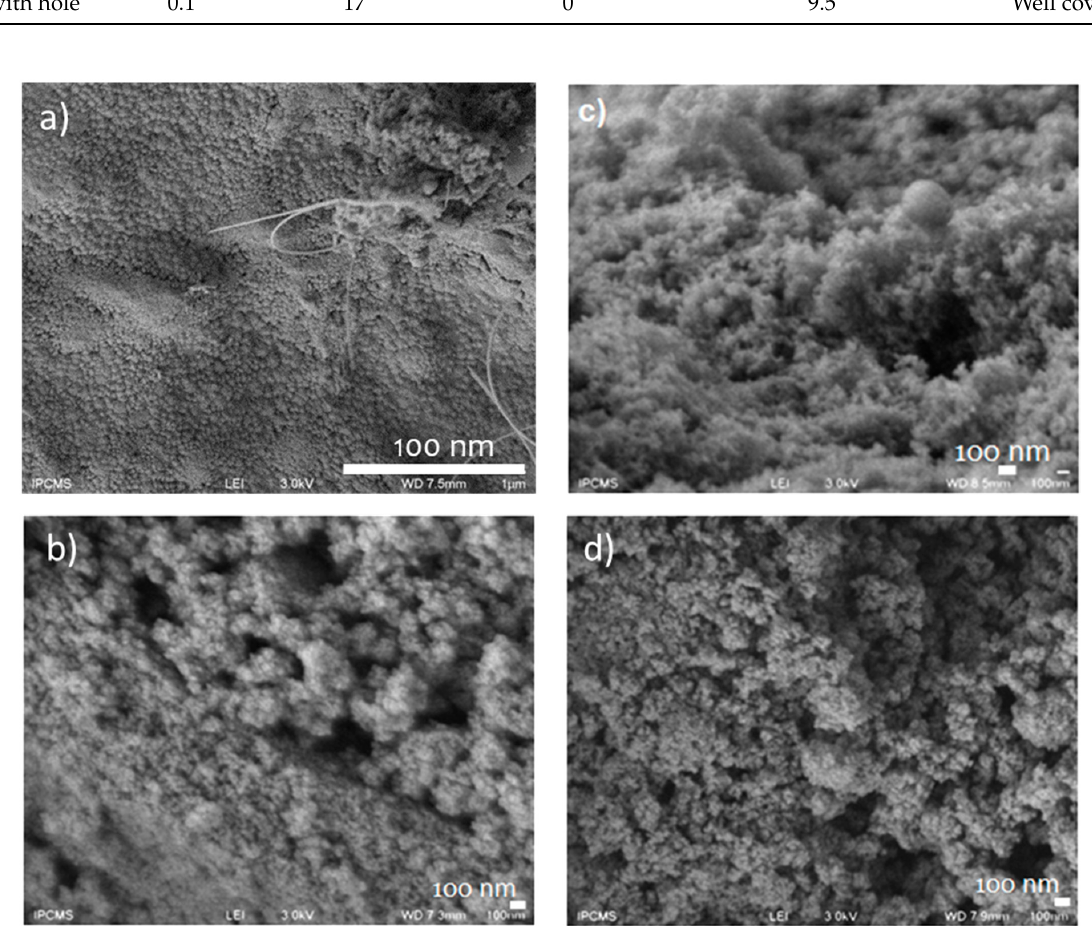
Figure 1. SEM images of β -SiC foams after HNO 3 treatment and calcined at 380 °C: ( a ) without catalyst, ( b ) with TiO 2 -P25, ( c ) with 8% Ta-doped TiO 2 /PEG and ( d ) with 1% Sn-doped TiO 2 /PEG.